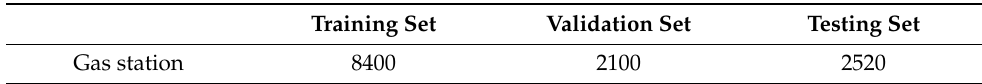
Table 1. The dataset